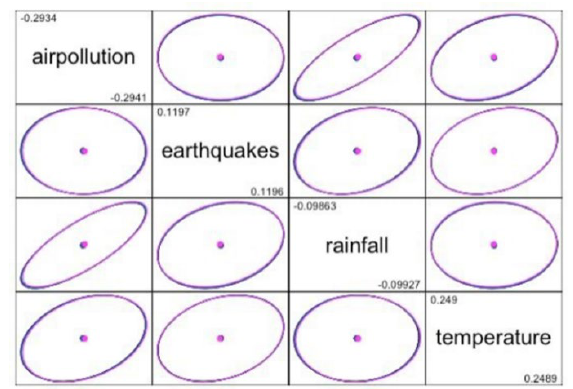
Figure 8. Pair Plots for Ridge